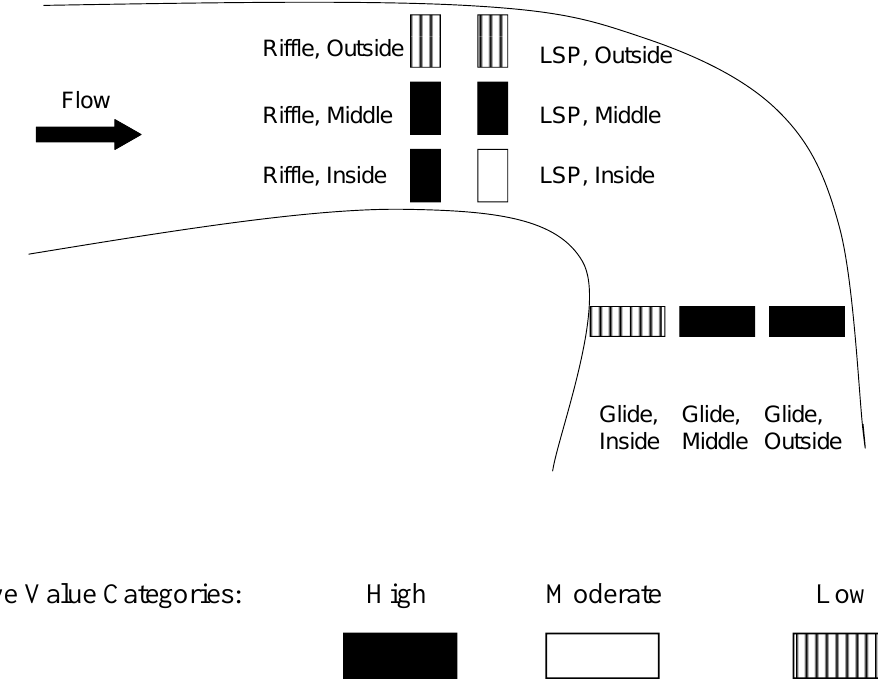
Figure 5. In situ depiction of pooled mean cell bed velocity (m·s −1 ) by habitat (Riffle, Lateral Scour Pool (LSP), Glide) x lateral position (Inside, Middle, Outside). The mussel bed would be located at LSP/Outside, which has a mean bed velocity in the low category. The relative value categories compare values of all cells within a river bend and the categories are based on significant differences identified through ANOVA habitat x lateral position interaction analysis.